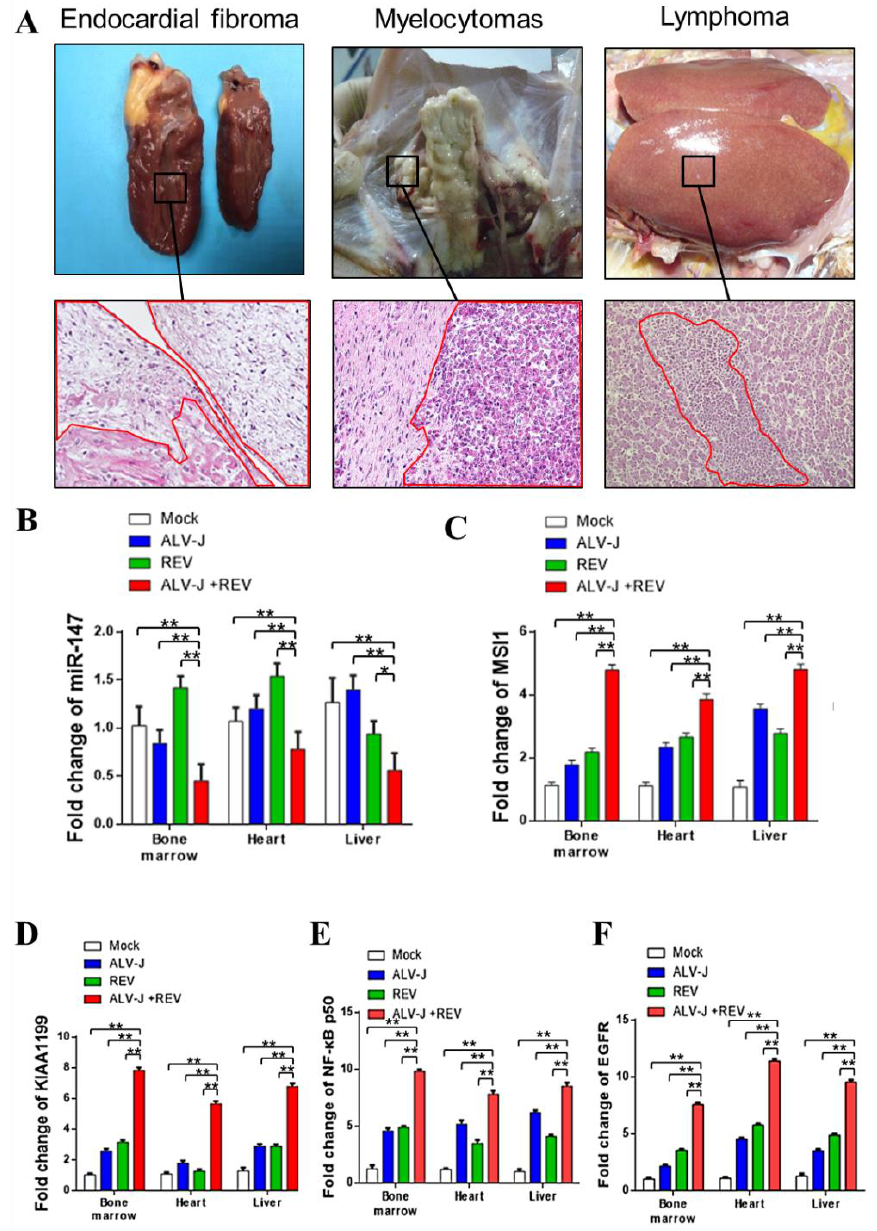
Figure 8. ALV-J and REV synergistically induced an increase in MSI1, KIAA1199, NF- κ B p50, and EGFR expression and decreased miR-147 expression levels in vivo. ( A ) ALV-J and REV synergistically induced endocardial fibroma, myelocytomas, and lymphomas in the hearts, bone marrow, and livers of chickens, inserts at 400 × magnification. Compared to the mono-infection group, RNA levels of MSI1 ( B ), KIAA1199 ( C ), NF- κ B p50 ( D ), and EGFR ( E ) were significantly upregulated, and RNA levels of miR-147 ( F ) were significantly downregulated in the bone marrow, livers, and hearts of chickens in coinfection group. ** p ≤ 0.01 determined using Student (cid:48) s t -test versus the Neg. Ctrl. group. * p ≤ 0.05 determined using Student (cid:48) s t -test versus the Neg. Ctrl.